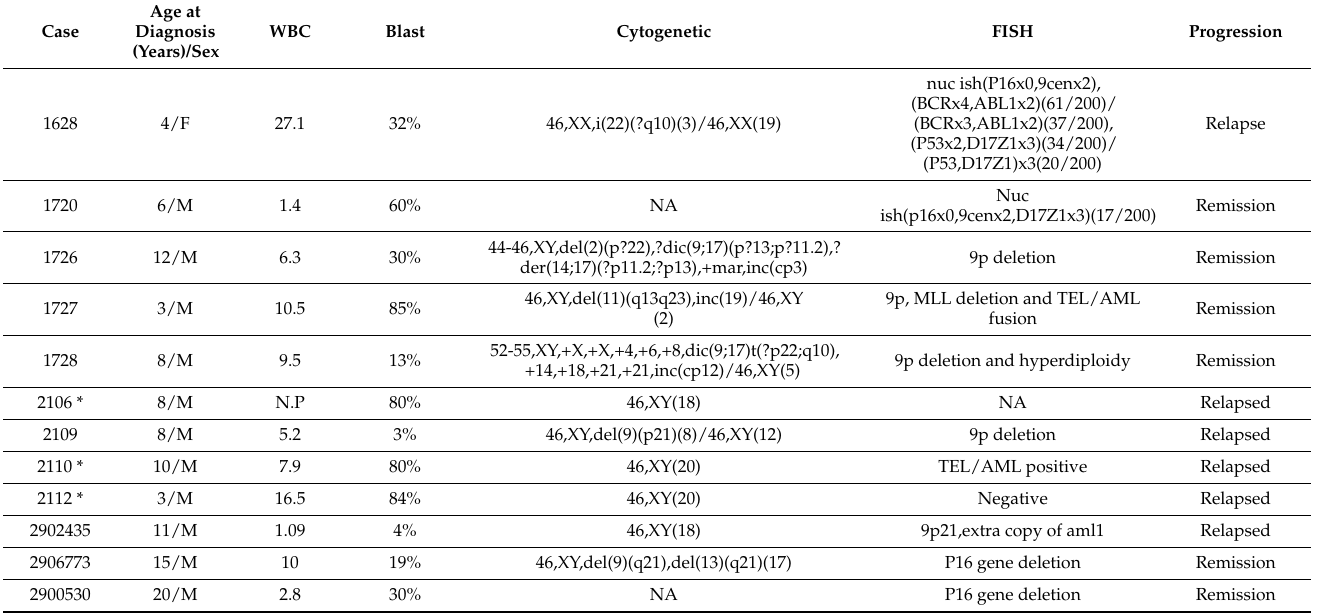
Table 1. Clinical Characteristics of the 12 B-ALL Patients Studied in this